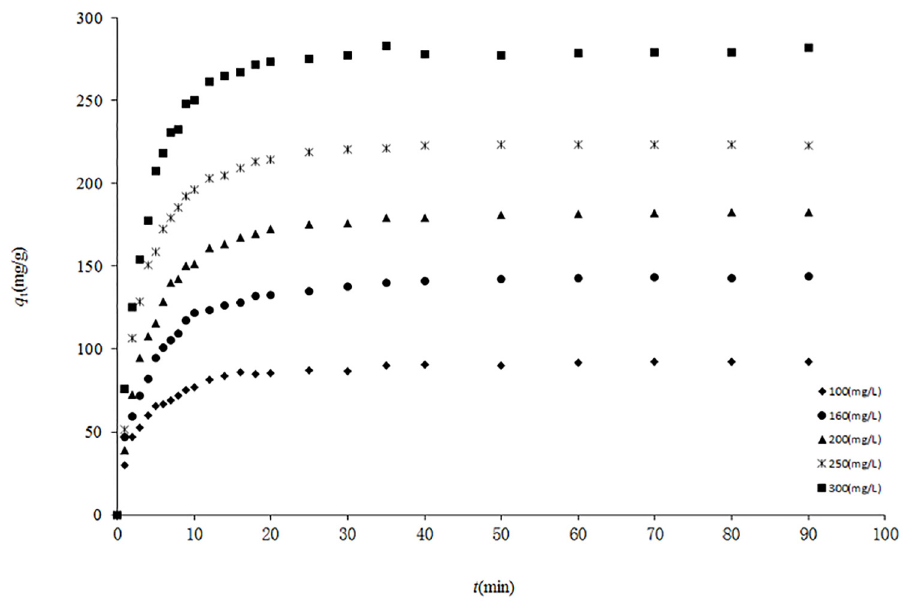
Fig 5. The curves of relations between q t and t at different initial concentrations. (experimental conditions: T = 303 K, pH = 5 and absorbent dosage = 0.10g).